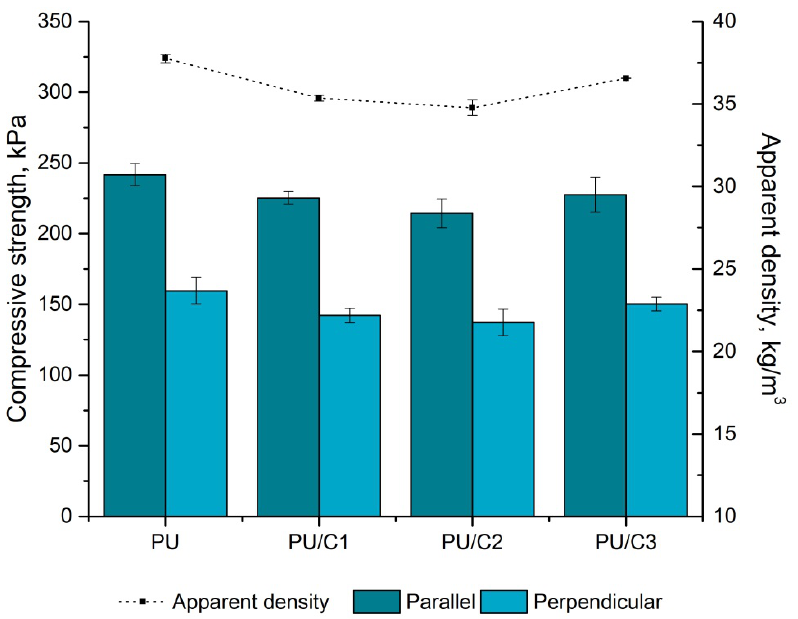
Figure 11. Changes in compressive strength and apparent density of PU foams with microcellu- lose.